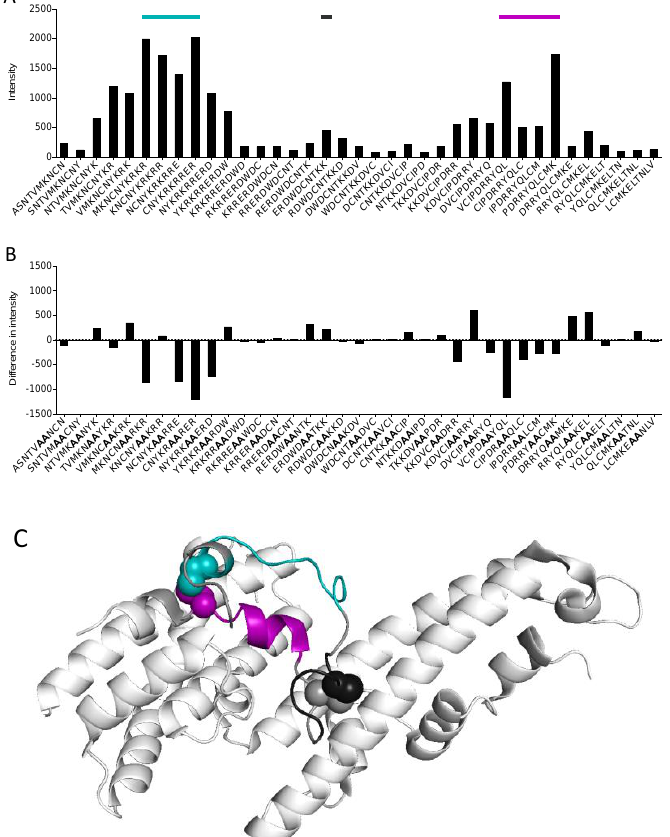
Figure 3. 3D10 recognizes a discontinuous epitope in SD1. ( A ) An overlapping peptide array spanning the SD1 region of DBPII was screened with 3D10. The colors of the lines above the bar graph correspond to the region of SD1 mapped to the structure in (C). ( B ) The intensity of 3D10 recognition of peptides with alanine substitutions (bolded) was subtracted from that of the native sequence. Negative values indicate that 3D10 recognition was decreased following alanine substitution. ( C ) The structure of SD1 was determined from a published crystal structure of DBPII that was adapted using PyMOL (PDB ID 4NUU). The cysteines involved in disulfide bonds are shown as space-filling